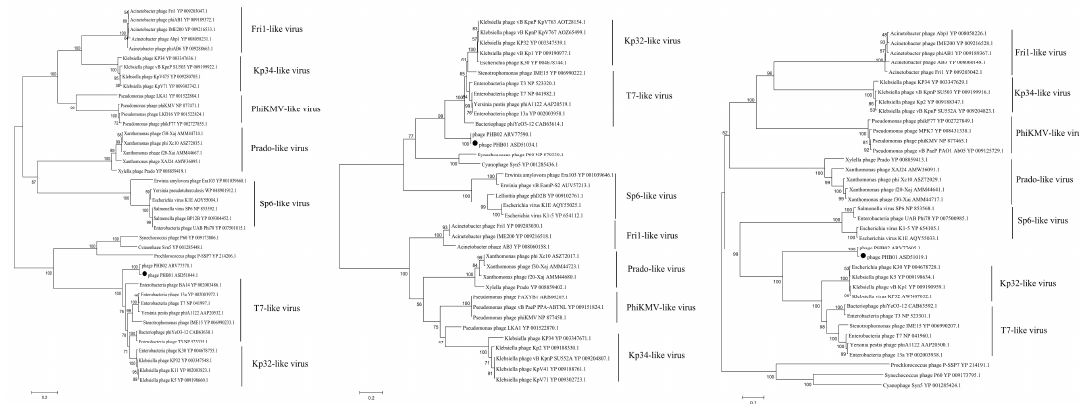
Figure 4. Phylogenetic tree analysis based on the alignments of amino acid sequences of the major capsid protein (( A ); Protein ID: ASD51044.1), the DNA polymerases (( B ); Protein ID: ASD51034.1), and the RNA polymerases (( C ); Protein ID: ASD51019.1) of the Autographivirinae subfamily phages from GenBank. Phage PHB01 is indicated by the black circle. The evolutionary trees were constructed using the neighbor-joining method with the Poisson correction model. One thousand bootstrap repetitions were performed. Sequences were aligned by the ClustalW package carried by MEGAX [35].